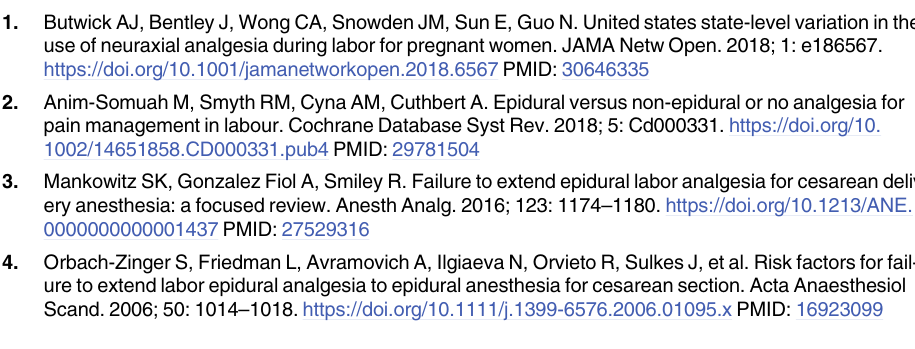
S1 Table. Features of isolated maternal fever and Triple I with classification. S2 Table. Primary outcome; CSEA subgroup analysis. S3 Table. Rate of conversion to general anesthesia. S4 Table. Secondary outcomes; CSEA subgroup